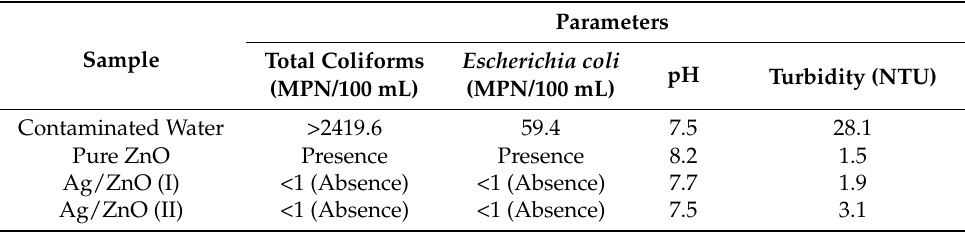
Table 3. Results validated according to the Standard Methods For The Examination of Water and Wastewater—23th